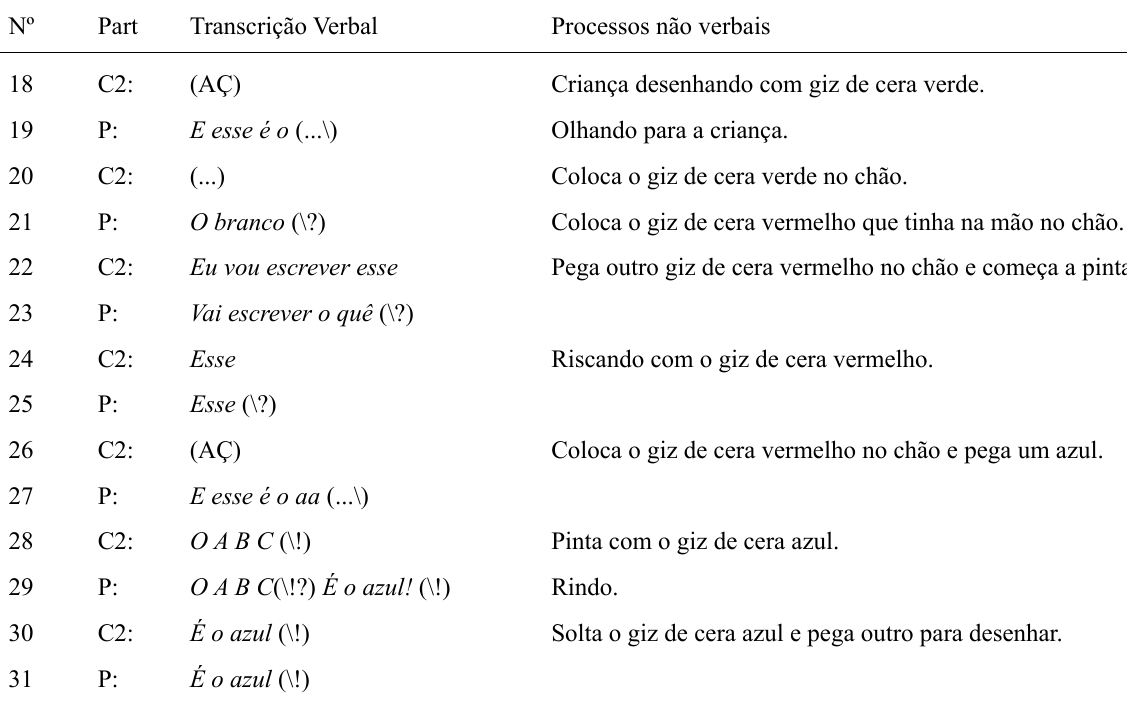
Falando Sobre as Cores dos Giz de